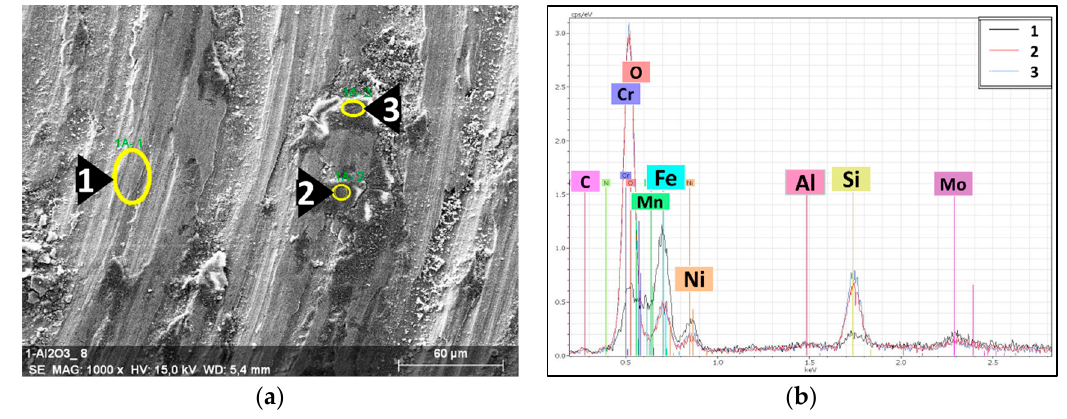
Figure 12. EDS spectra with the associated SEM images of the tribological wear track of the 316L/0.33 wt% Al 2 O 3 . ( a ) SEM image of the wear track; ( b ) EDS spectra of the selected spots.